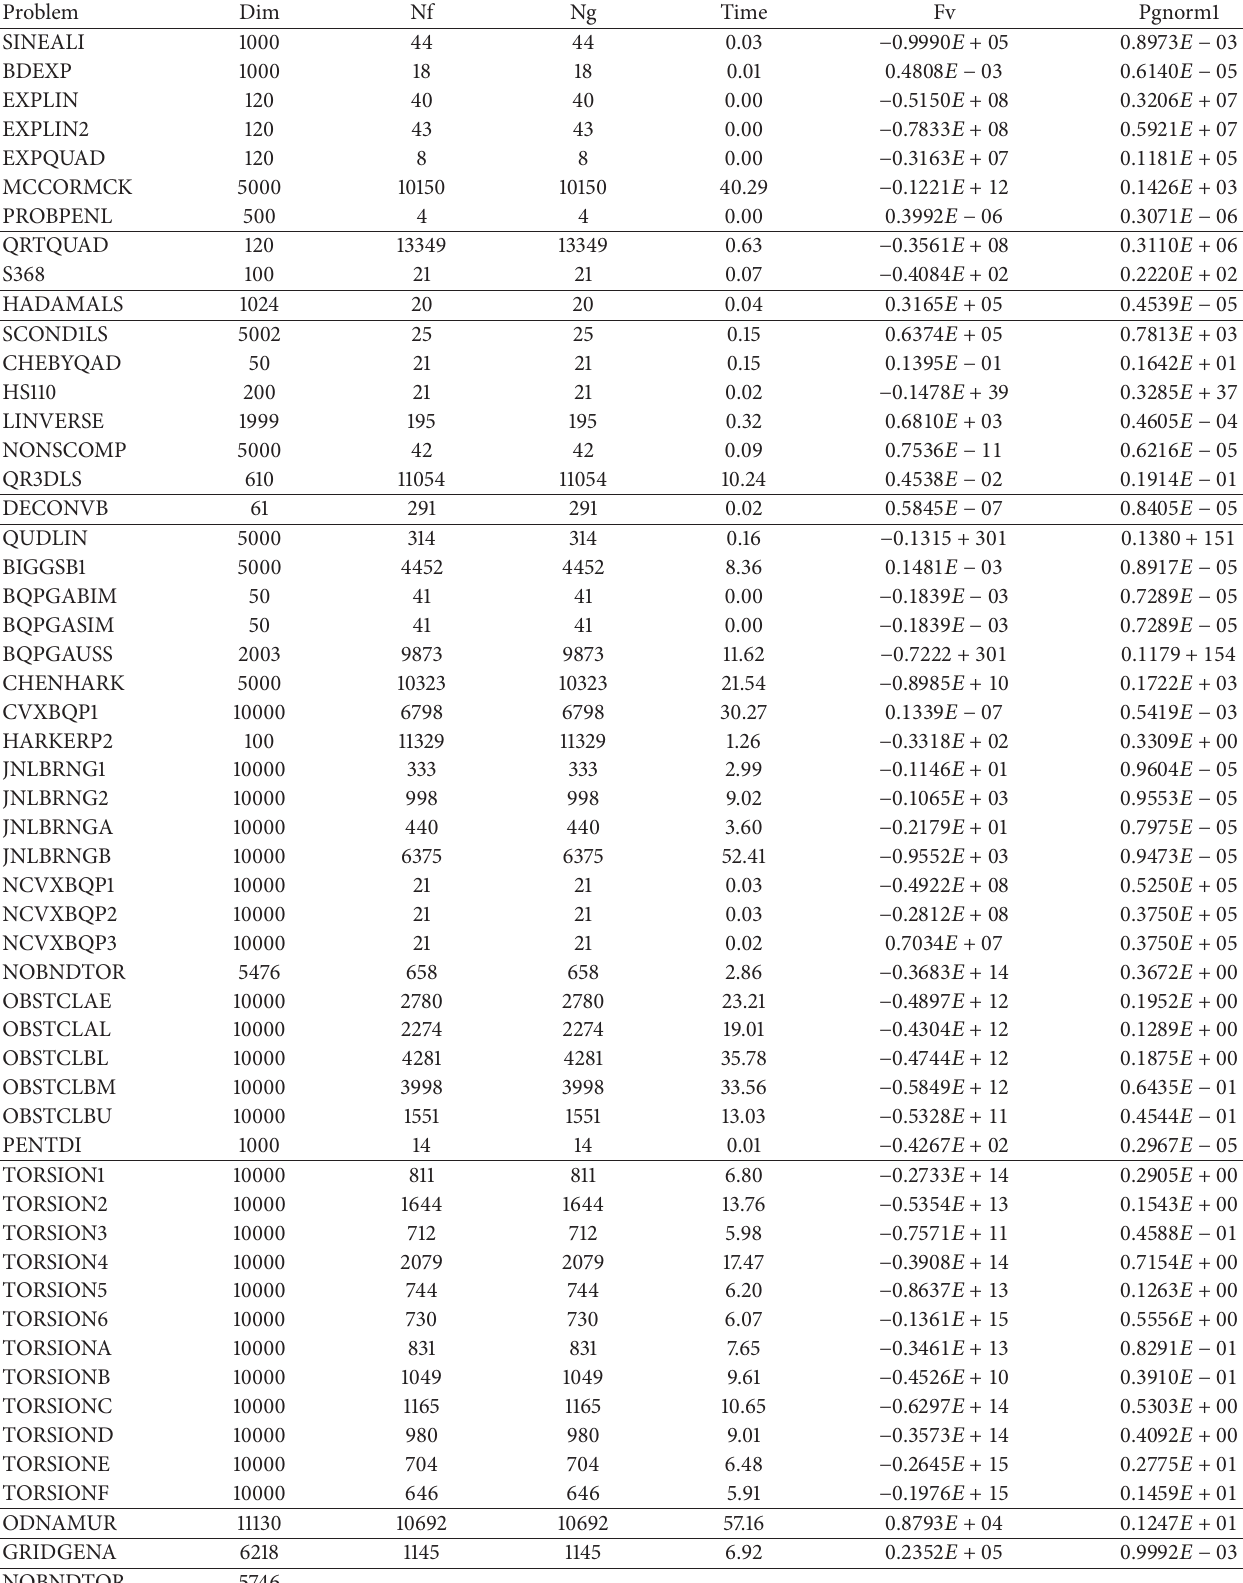
Table 3: Performance of